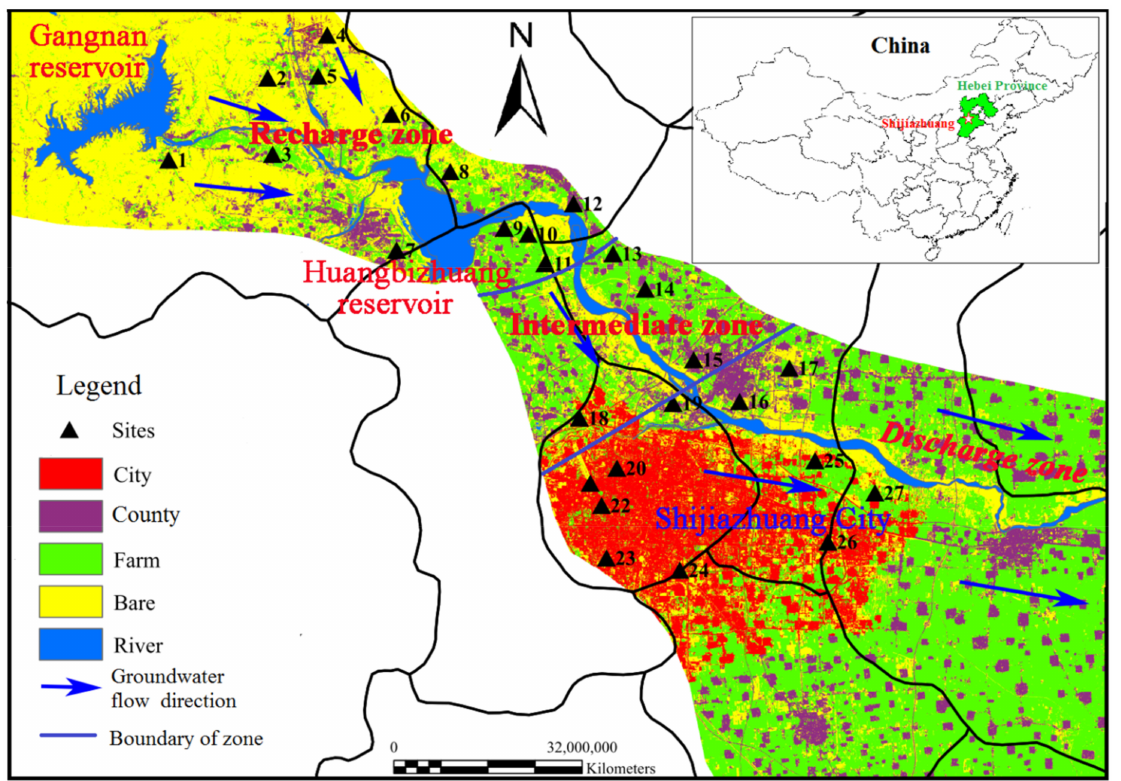
Figure 1. Water quality monitor sites and land use types of the Hutuo River alluvial-pluvial fan in